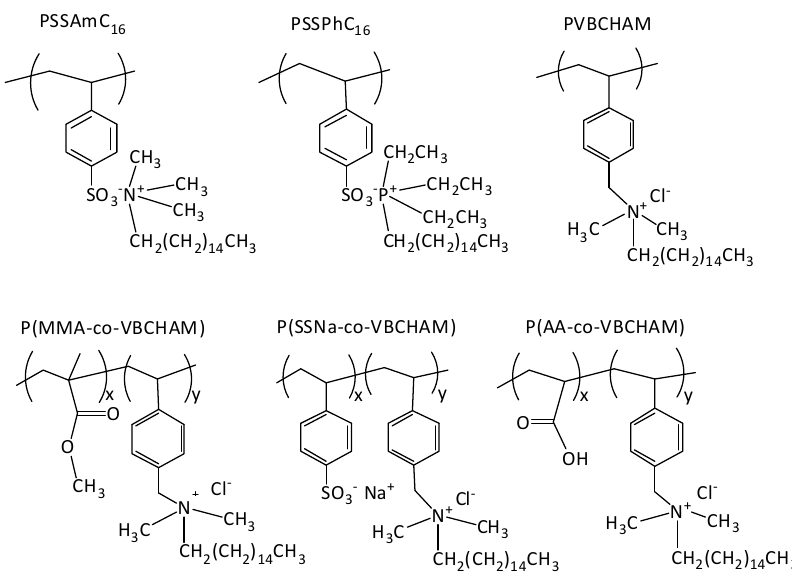
Figure 1. Chemical structures of the homopolymers PSSAmC 16 , PSSPhC 16 , PVBCHAM and the copolymers P(MMA-co-VBCHAM), P(SSNa-co-VBCHAM), P(AA-co-VBCHAM).